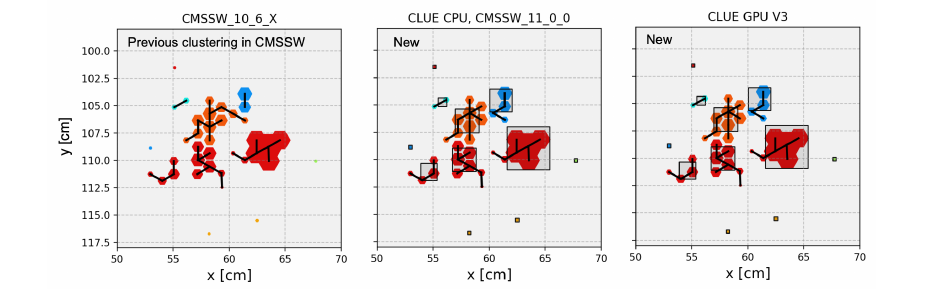
Figure 4. Example of clustering result from previous algorithm in CMSSW_10_6_X ( left ) and CLUE- CPU ( middle ) and CLUE-GPU ( right ). The example shows a small region on the 12 th layer of a simu- lated of t ¯ t event.